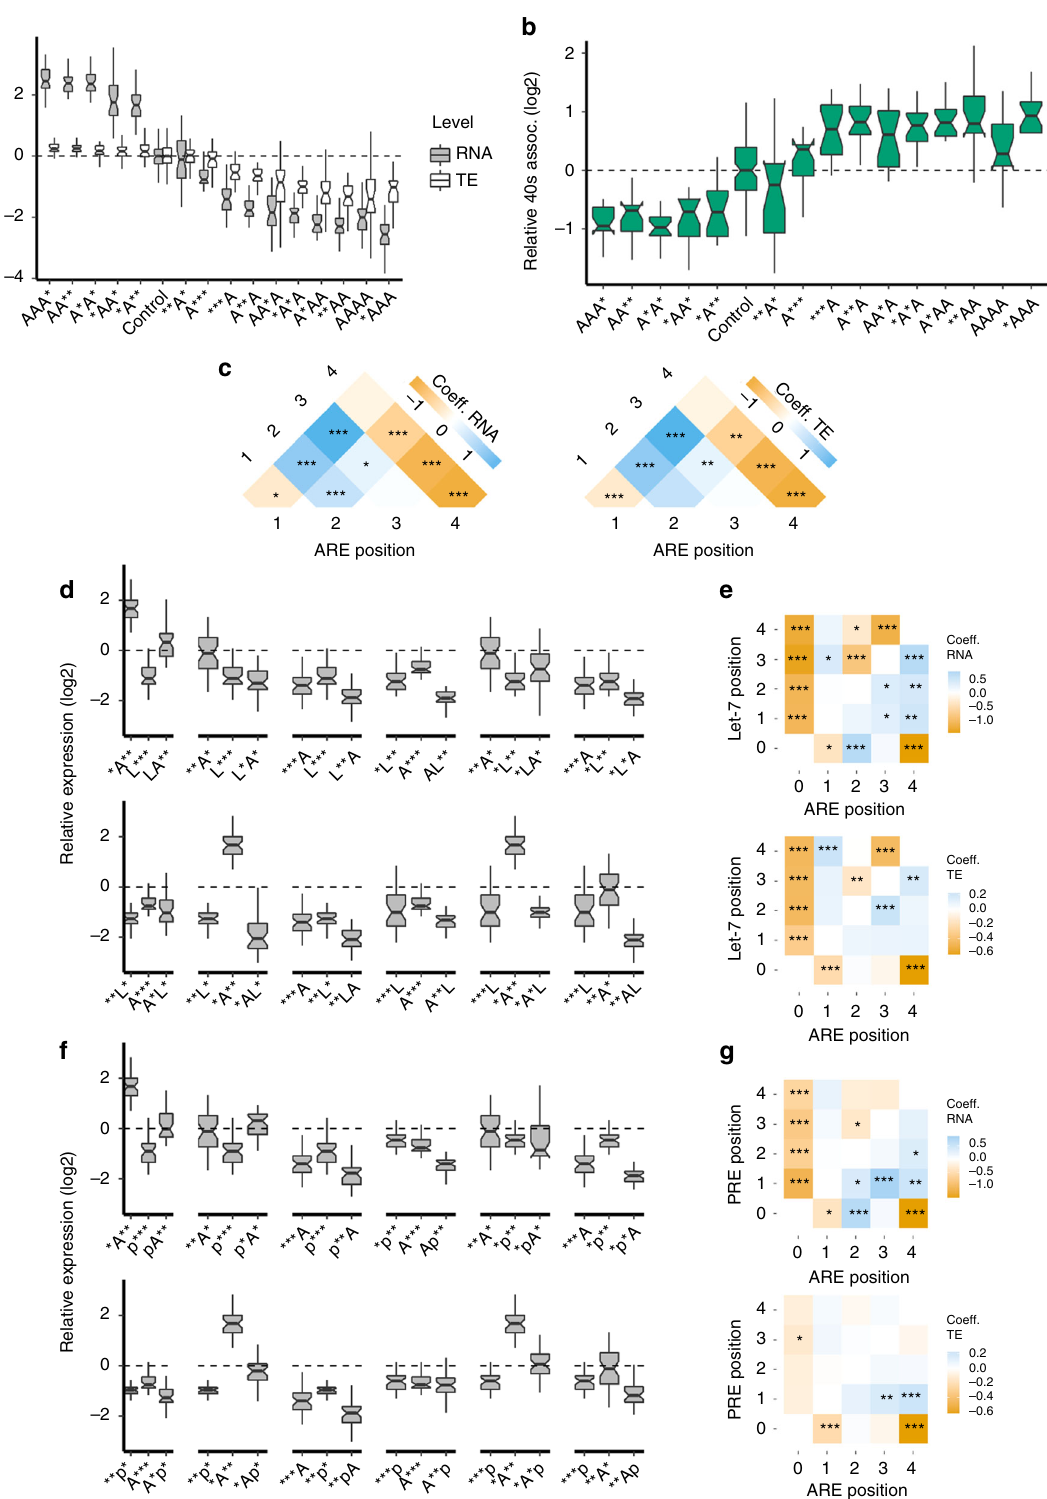
Fig. 5 AU-rich elements modulate repression by Pumilio and miRNAs. a The position of an ARE within the synthetic 3 ′ UTR determines the relative TE or RNA expression. b The relative 40s association of ARE containing reporters. c Heatmap of the regression coef fi cients for the parameters corresponding to AREs alone. Left panel shows coef fi cients for RNA expression and the right panel shows coef fi cients for TE. d AREs modulate repression by miRNAs in a position- dependent manner. The green box highlights an example of stimulation of miRNA-mediated RNA destabilization by an ARE. e The regression coef fi cients for the parameters corresponding to let-7 or AREs alone or interactions between positions containing let-7 or ARE. f AREs modulate repression by PREs in a position dependent manner. g The regression coef fi cients for the parameters corresponding to PREs or AREs alone or interactions between positions containing PRE or ARE. For a , b , d and f , * = Blank, A = ARE, L = let-7 and p = PRE. For c , e and g , * P < 0.05, ** P < 0.01, *** P < 0.001, t -test. Boxplot whiskers indicate the furthest datum that is 1.5*Q1 (upper) or 1.5*Q3 (lower). For clarity, outliers have been removed from boxplots but were used for statistical